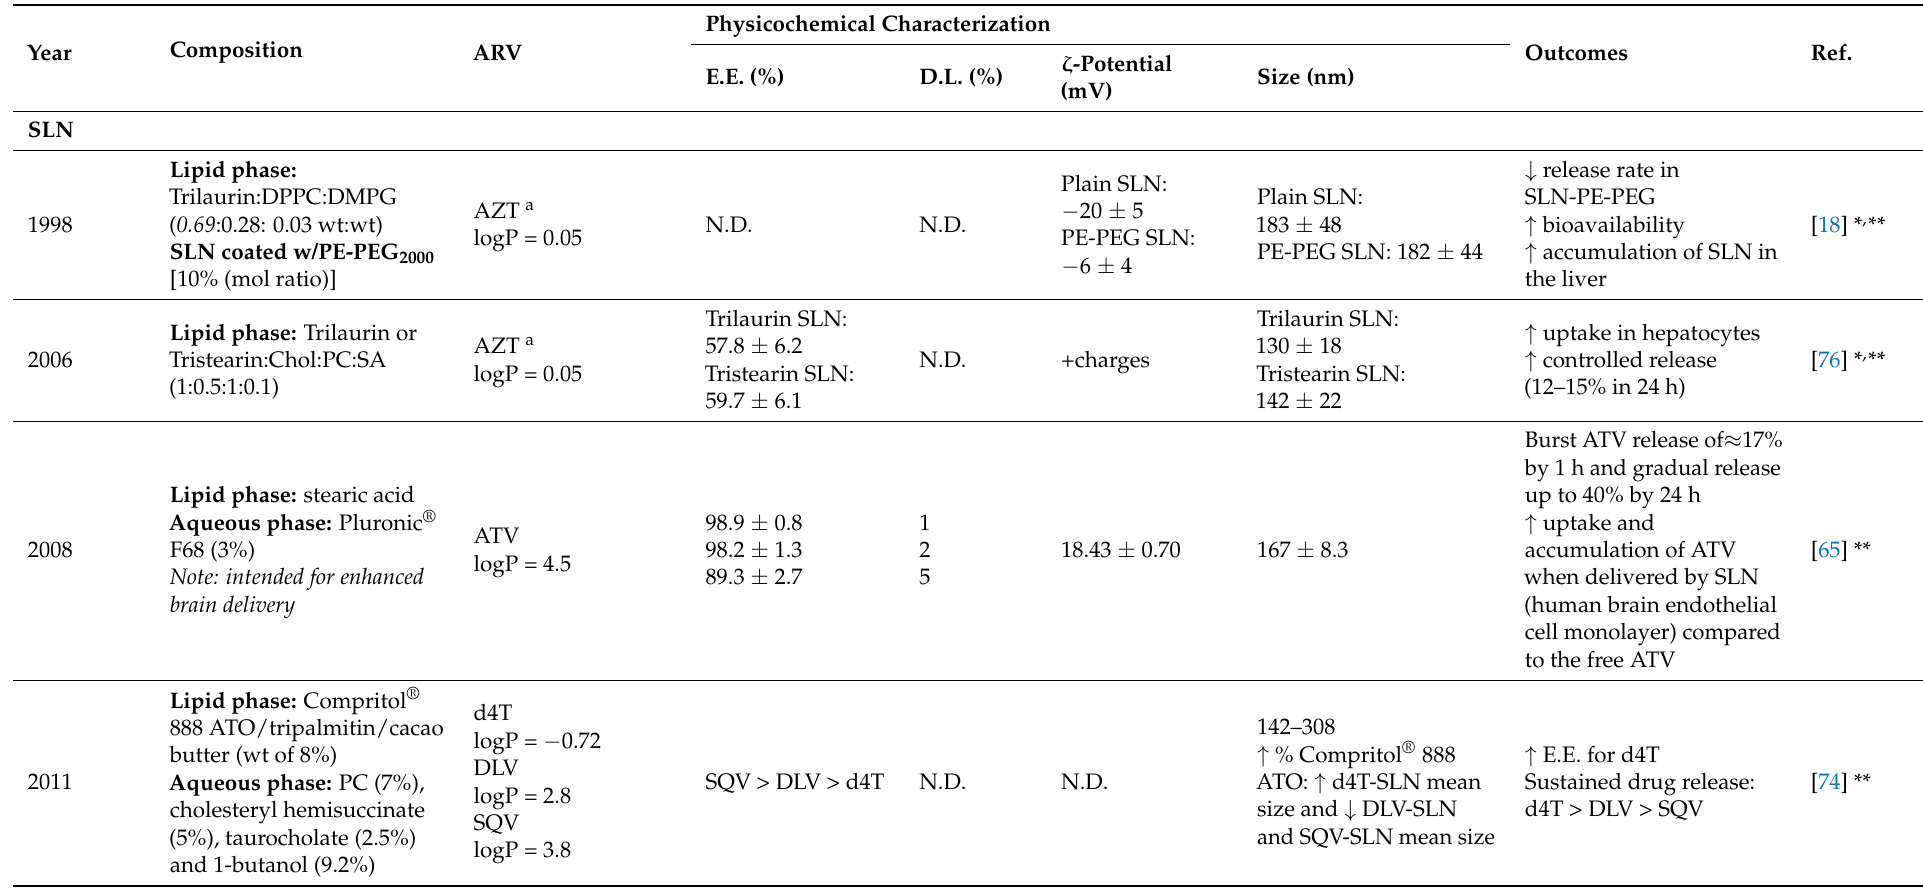
Table 4. Lipid nanoparticles (SLN and NLC) for ARV